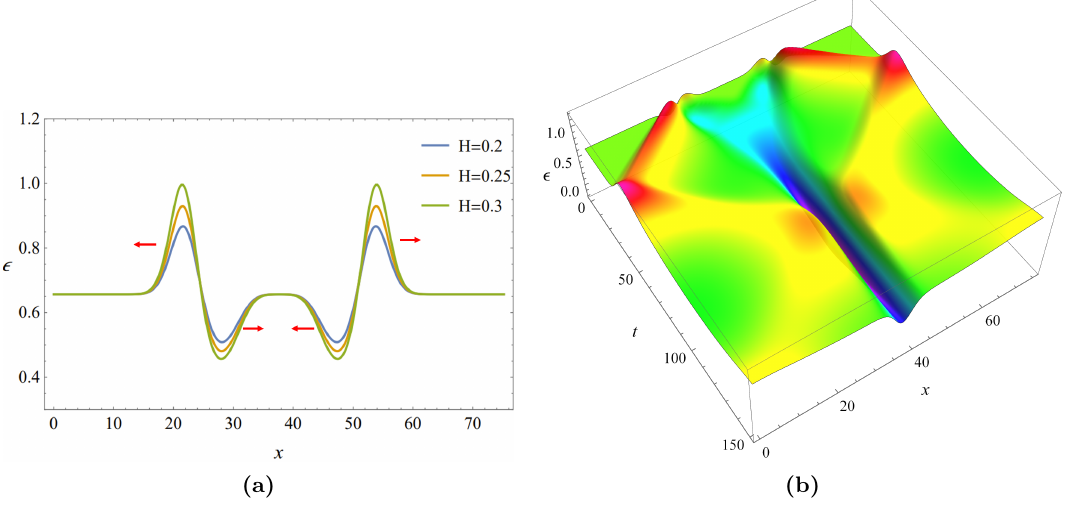
Figure 7. (a): the energy density at time t = 5 with different quench strength H . (b): the energy density as a function of time in the collision process of shock waves. Note that in this plot, we have only illustrated the fully nonlinear evolution up to the intermediate critical state.